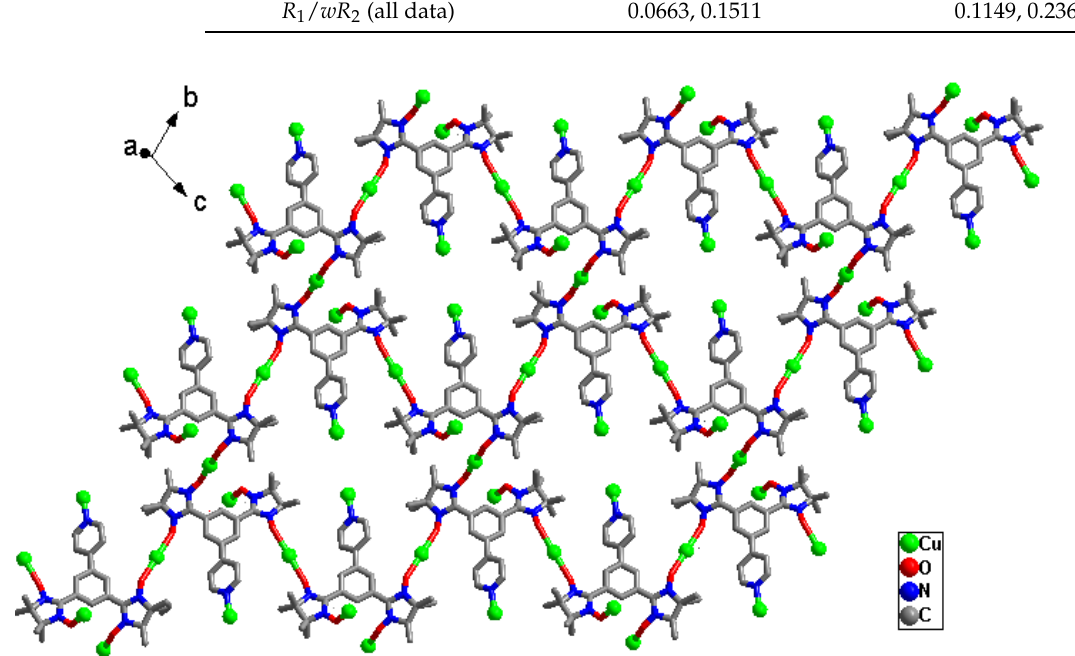
Figure 1. Asymmetric unit of the reticular complex in 1 . The H and F atoms are left out (a: − x + 2, − y, − z; b: − x + 2, − y + 1, − z).